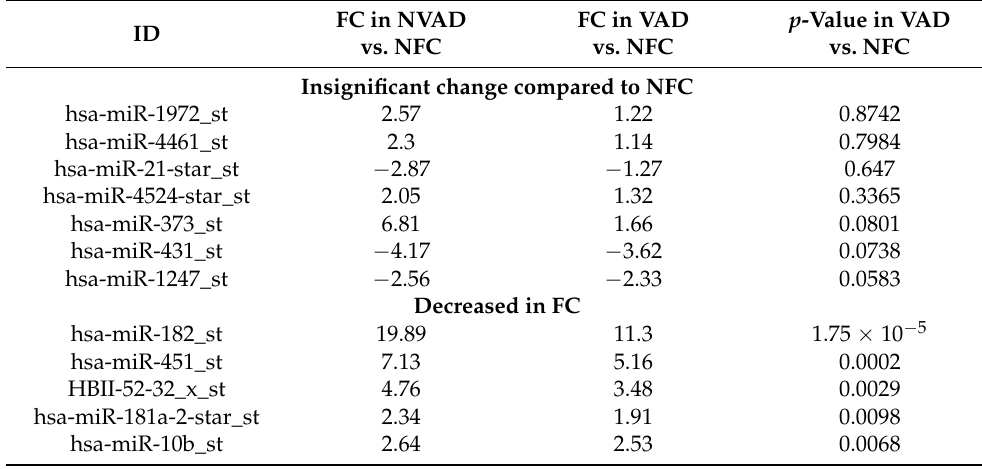
Table 5. Changes in pathological miRNA expression post-LVAD implantation in the